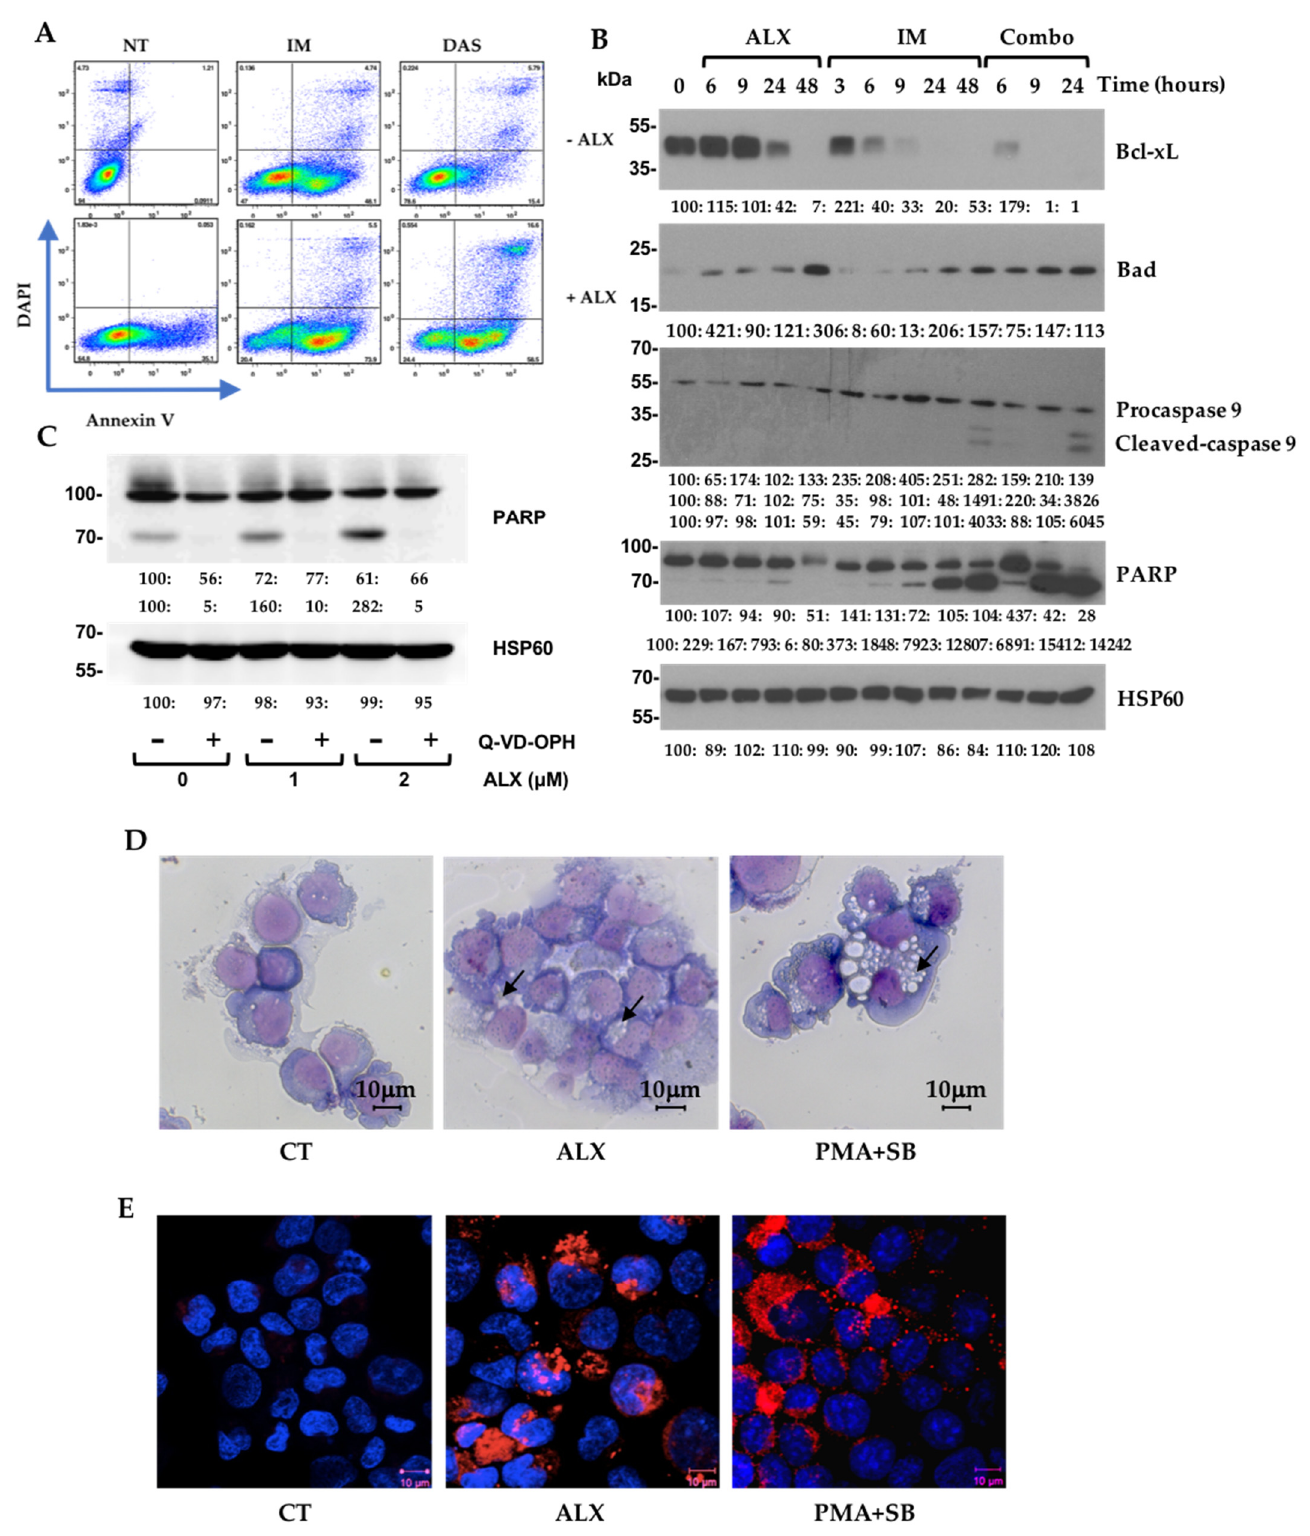
Figure 3. Combinations of ALX and imatinib induced apoptotic and autophagic events in K562 cells: ( A ) K562 cells were stimulated or not with 1 μ M alexidine (ALX) alone or in combination with 1 μ M imatinib (IM) for 24 h. Cytometry analysis after annexin V/DAPI labeling ( left panel ). Histograms for annexin V+ DAPI+ cells ( top-right panel ) and annexin V+ DAPI − cells ( bottom-right panel ); ( B ) K562 cells were stimulated or not with 1 μ M alexidine (ALX), 1 μ M imatinib (IM), or their combina-